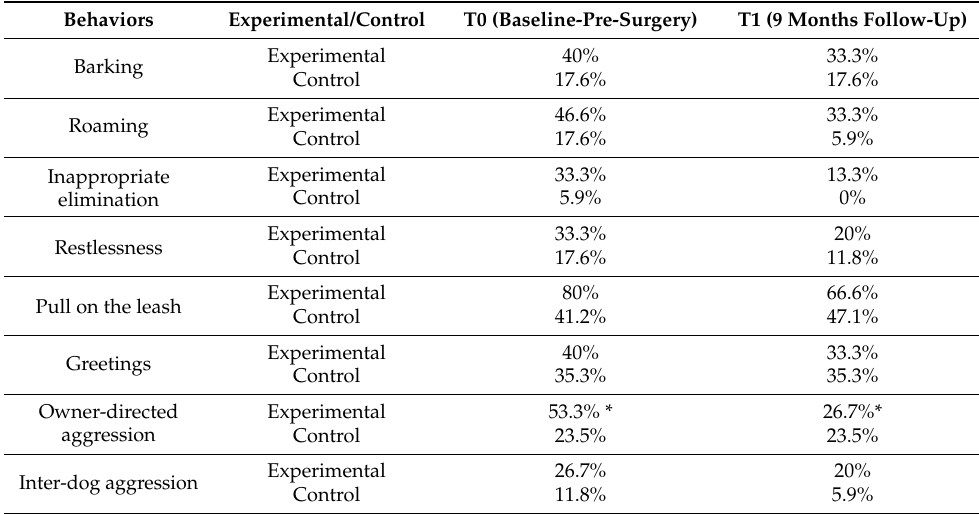
Table 5. Age of female dogs (experimental and control) at T0 .